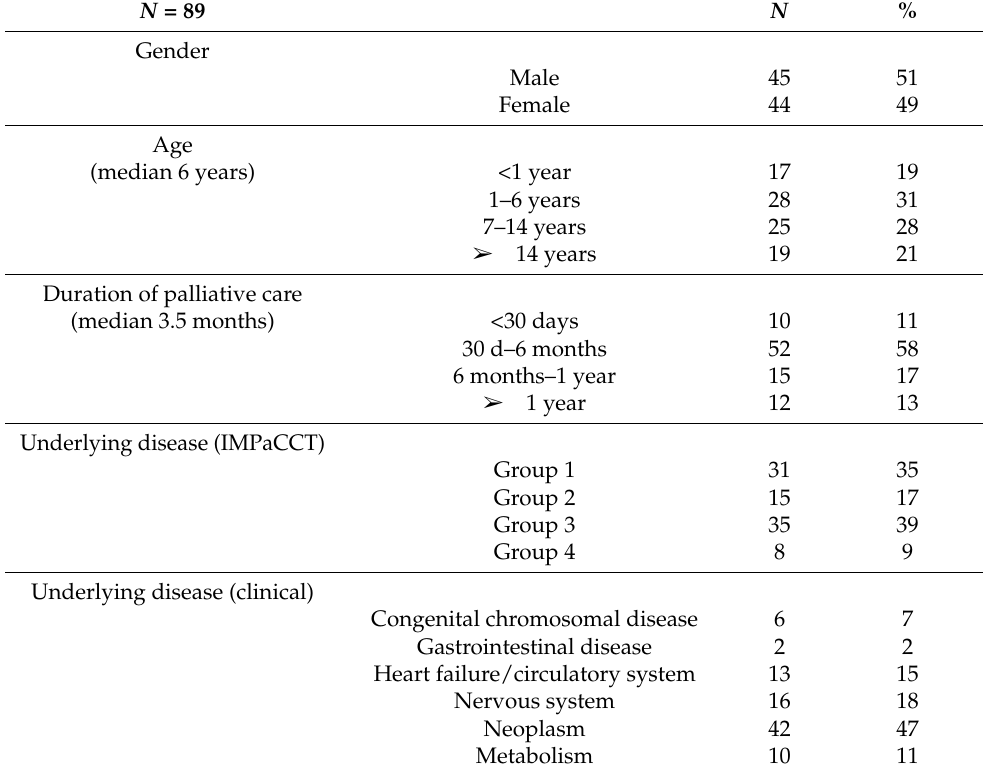
Table 1. Patient